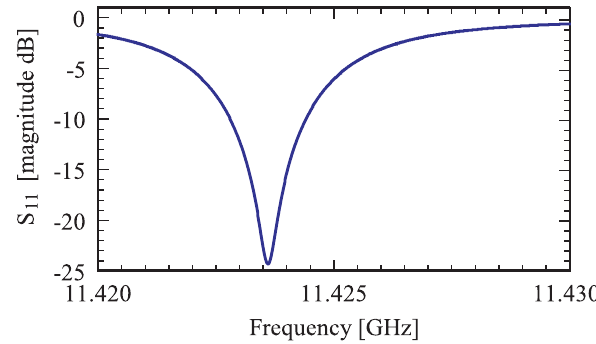
FIG. 7. Reflection as a function of frequency for PBG struc- ture, as calculated.